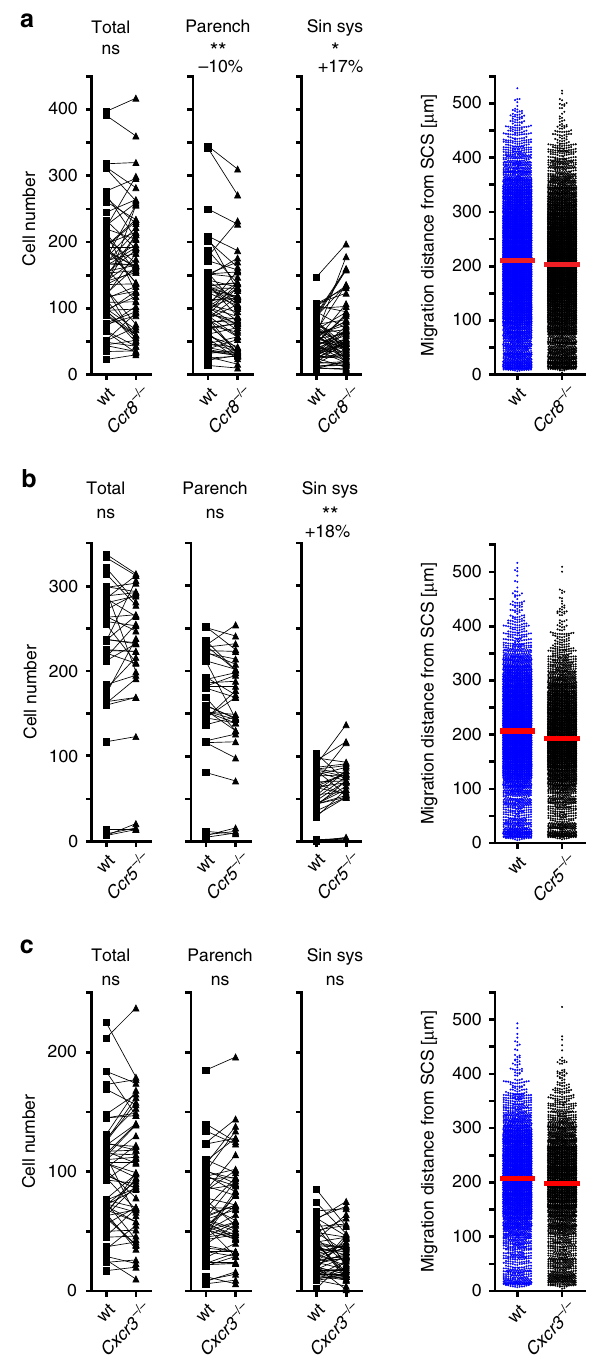
Fig. 7 CCR5 and CCR8 but not CXCR3 contribute to homing of lymph- derived activated CD4 T cells to LNs. Quantitative analysis of adoptively transferred cells in popliteal LNs 90 min after i.l. injection of combinations of activated CD4 + T cells as indicated; a wild type and Ccr8 − / − ; b wild type and Ccr5 − / − ; c wild type and Cxcr3 − / − . Left, total cell counts; dots represent cell counts per LN section; numbers above indicate the percentage of change compared to control cell population (parench parenchyma; sin. sys. sinus system). Right, migration distance from the SCS; dots represent the shortest distance of each cell to the SCS; red bars, median; ns, not signi fi cant; Wilcoxon signed rank test; * p < 0.05; ** p < 0.01. Data are derived from three experiments with a total of nine ( a ) or eight ( c ) mice, or from two experiments with a total of fi ve ( b )